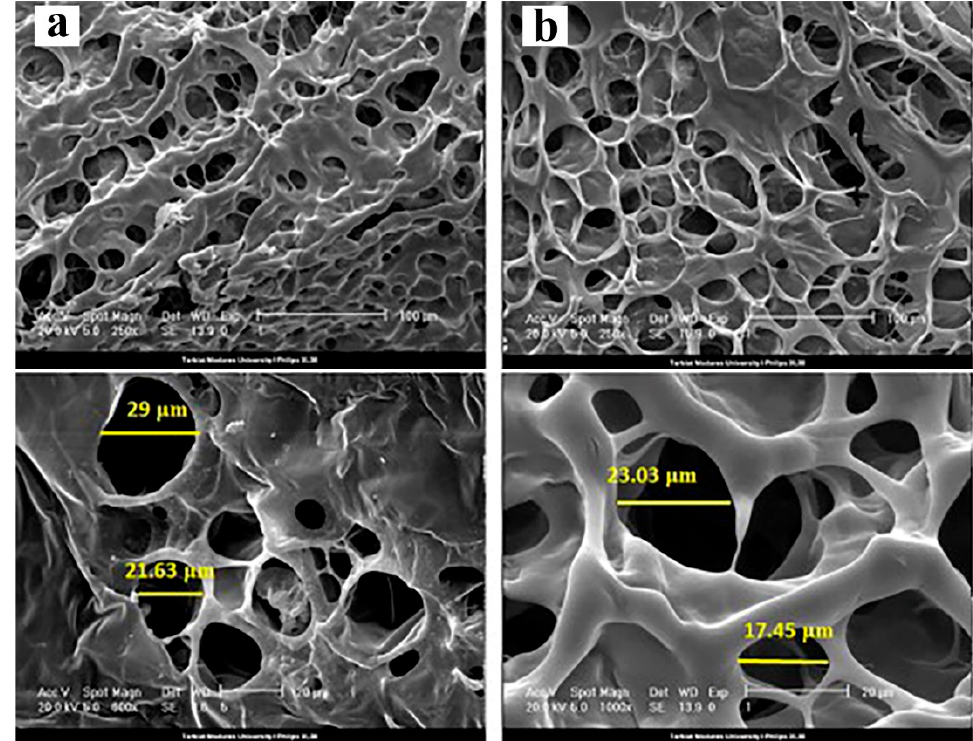
Figure 5. SEM of the surface morphology of ( a ) collagen-gelatin hydrogels with average diameters between 10 and 30 μ m and ( b ) gelatin hydrogels with average diameters between 20 and 30 μ m [74]. It should be mentioned that section (a) and (b) are used with permission from [74]. Copyright Elsevier, 2019.